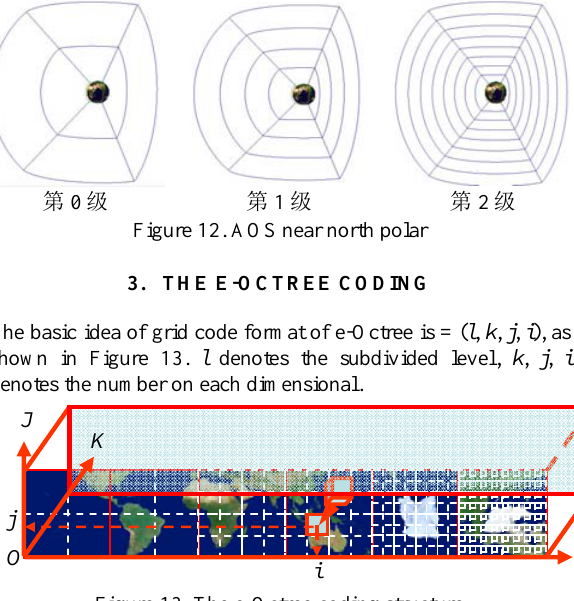
Figure 11. AOS near equator